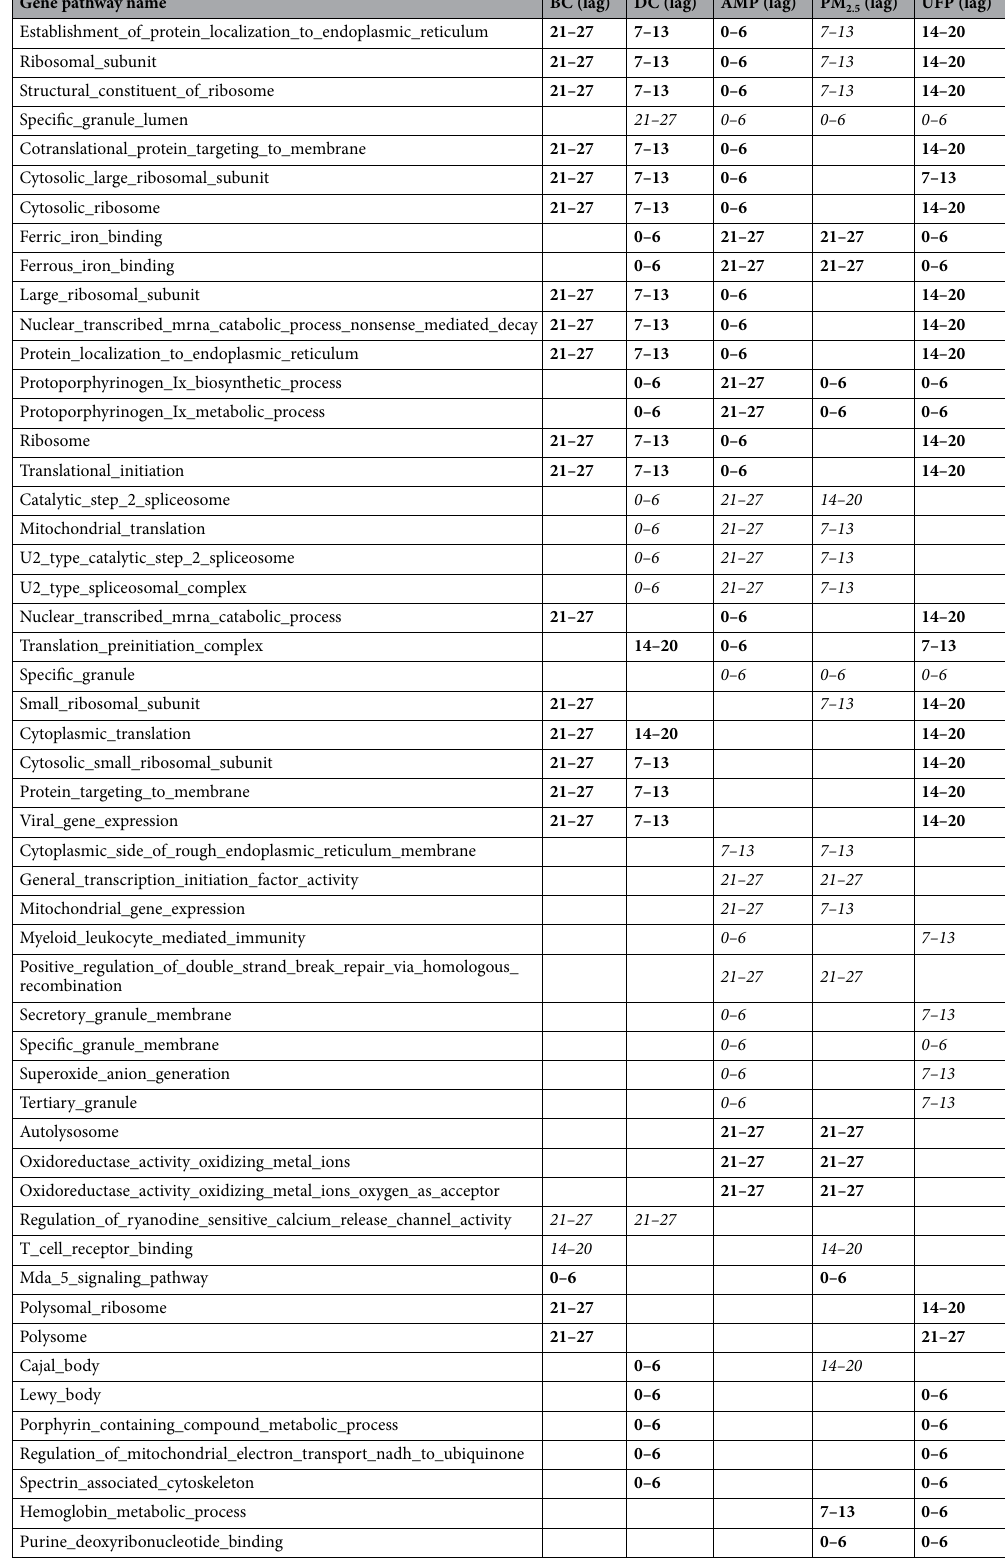
Table 3. Pattern of association between gene pathways and increased concentrations of multiple particulate matter pollutants at multiple lag times (bold-upregulated,